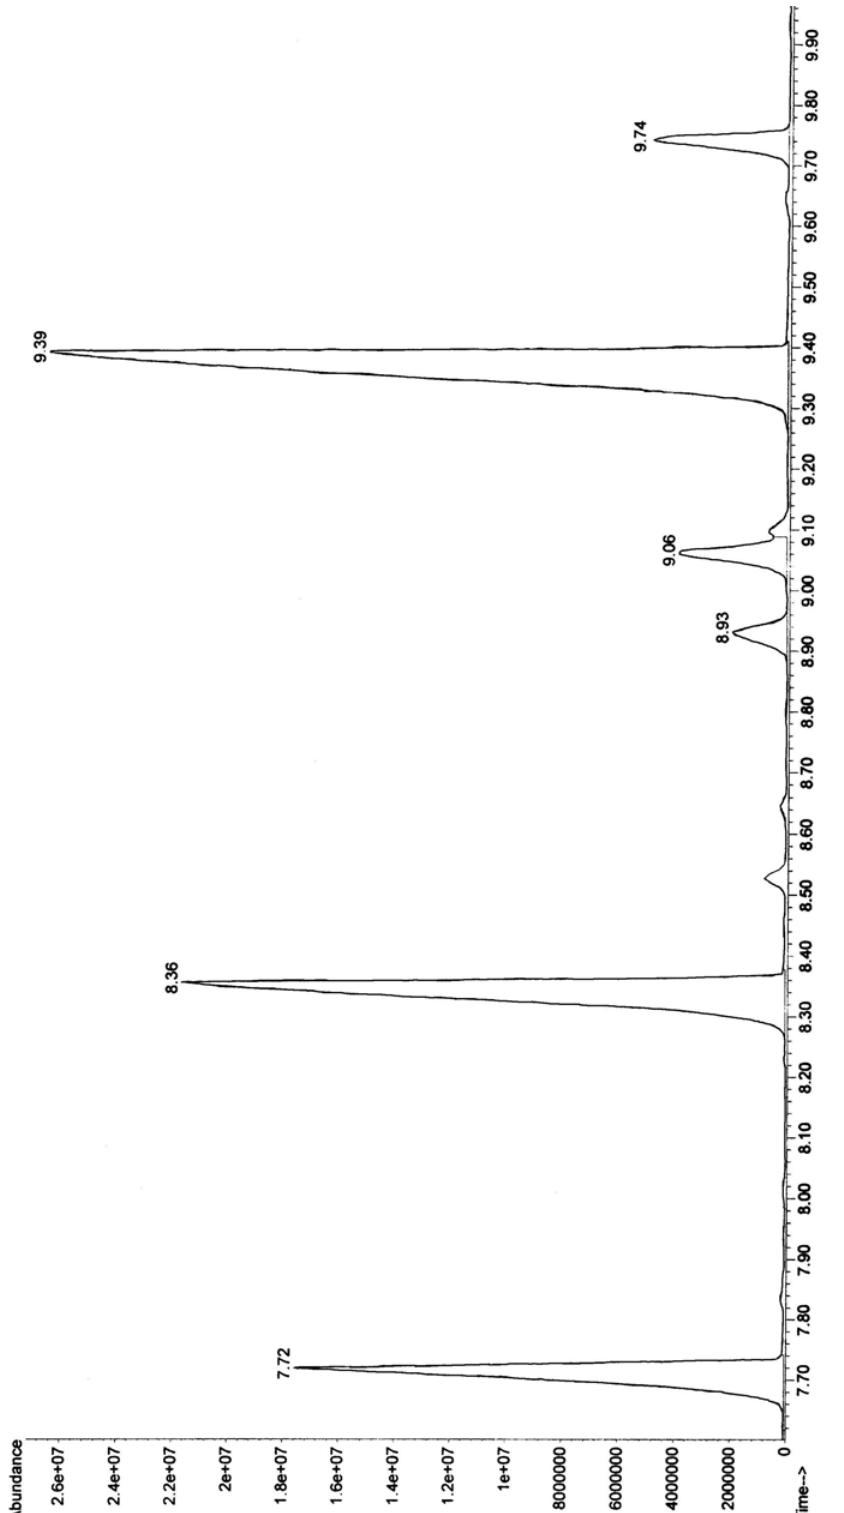
Figure 1a: Gas chromatograms of lecithin hydrolysate obtained in presence of 0.5 mol/l NaOH. (Incubation time: 25 min at the conditions described in the text). t (16:0); t =8.36 Internal Standard (Heptadecanoic acid, 17:0); t R t =9.06 Oleic acid (18:1); t =9.39 Linoleic acid (18:1); t R R